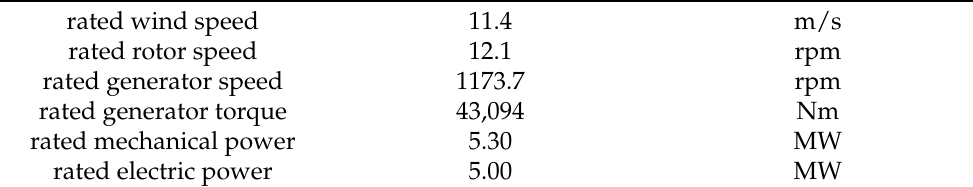
Table 3. Rated operation point for the wind